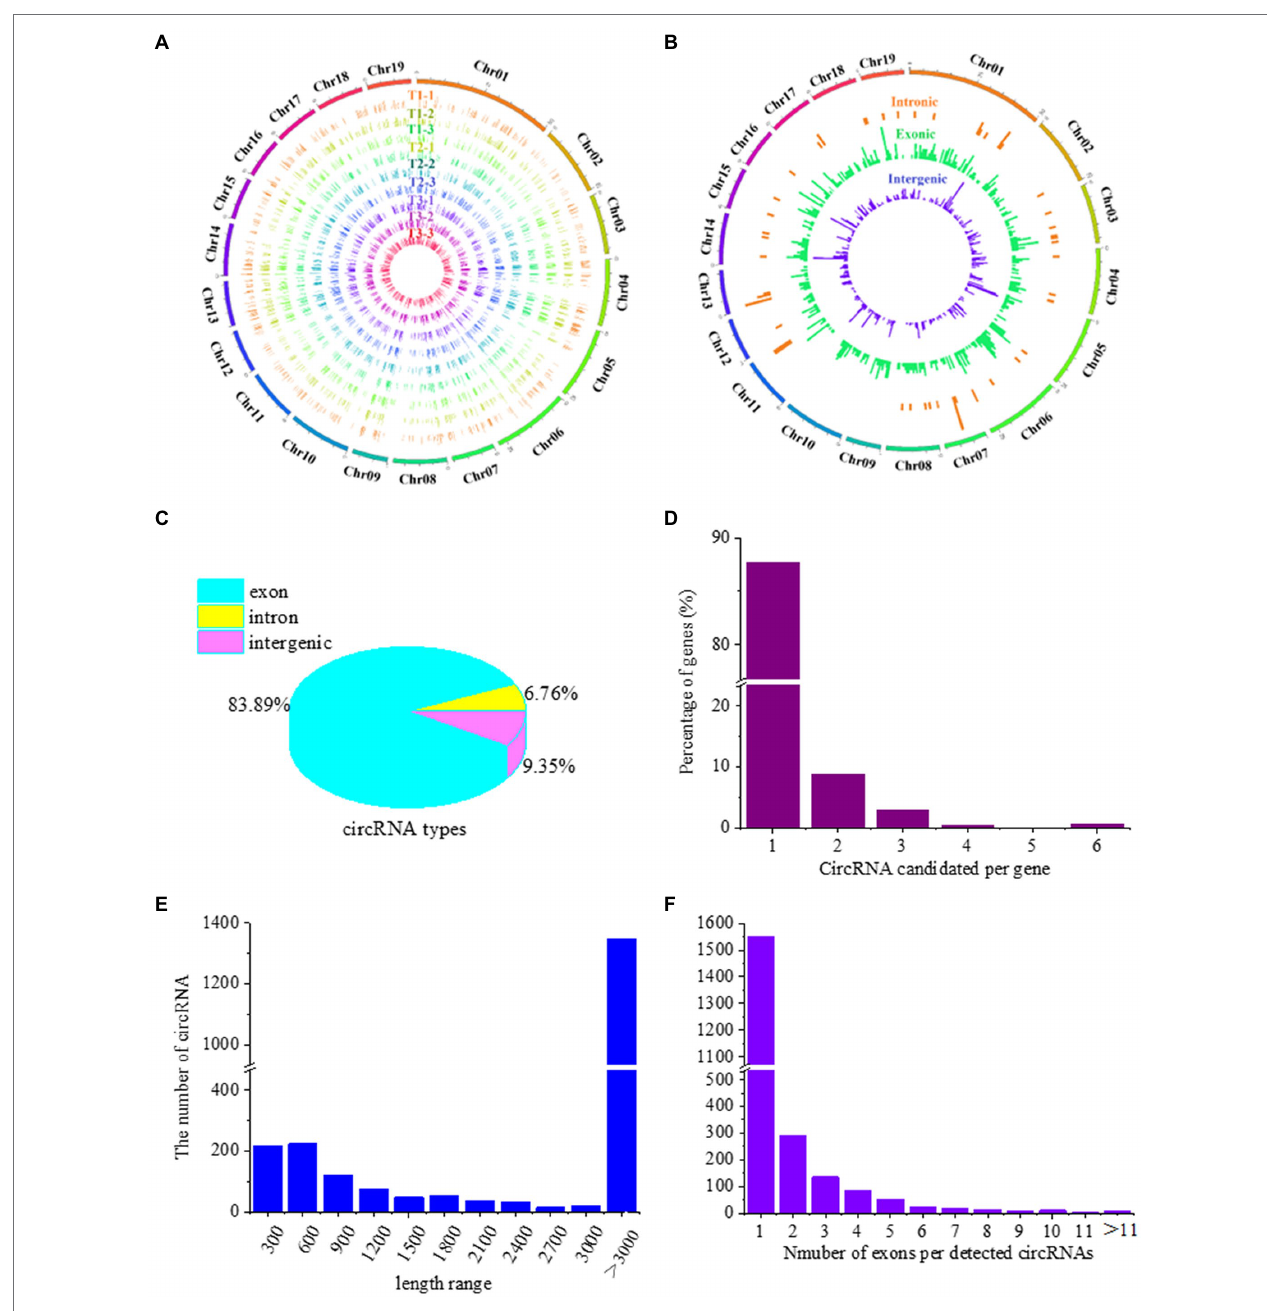
FIGURE 1 | Genomic features of identified circRNAs in the roots of P. × canescens treated with NO 3− (T1), NH 4+ NO 3− (T2), and NH 4+ (T3) conditions for 21 days. (A) The expression level of circRNAs along the 19 chromosomes. (B) Chromosomal distribution of the three types (exonic, intronic, and intergenic circRNAs). (C) The proportion of the three types of identified circRNAs. (D) Percentage of hosting protein-coding genes that generated different circRNA candidates. (E) Length distribution of circRNAs. (F) The number of exons per